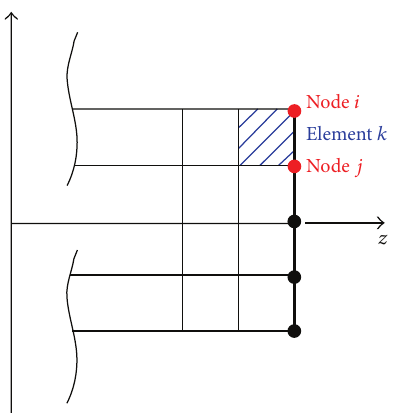
estimated for the 1D concept beams are listed in Table 2.